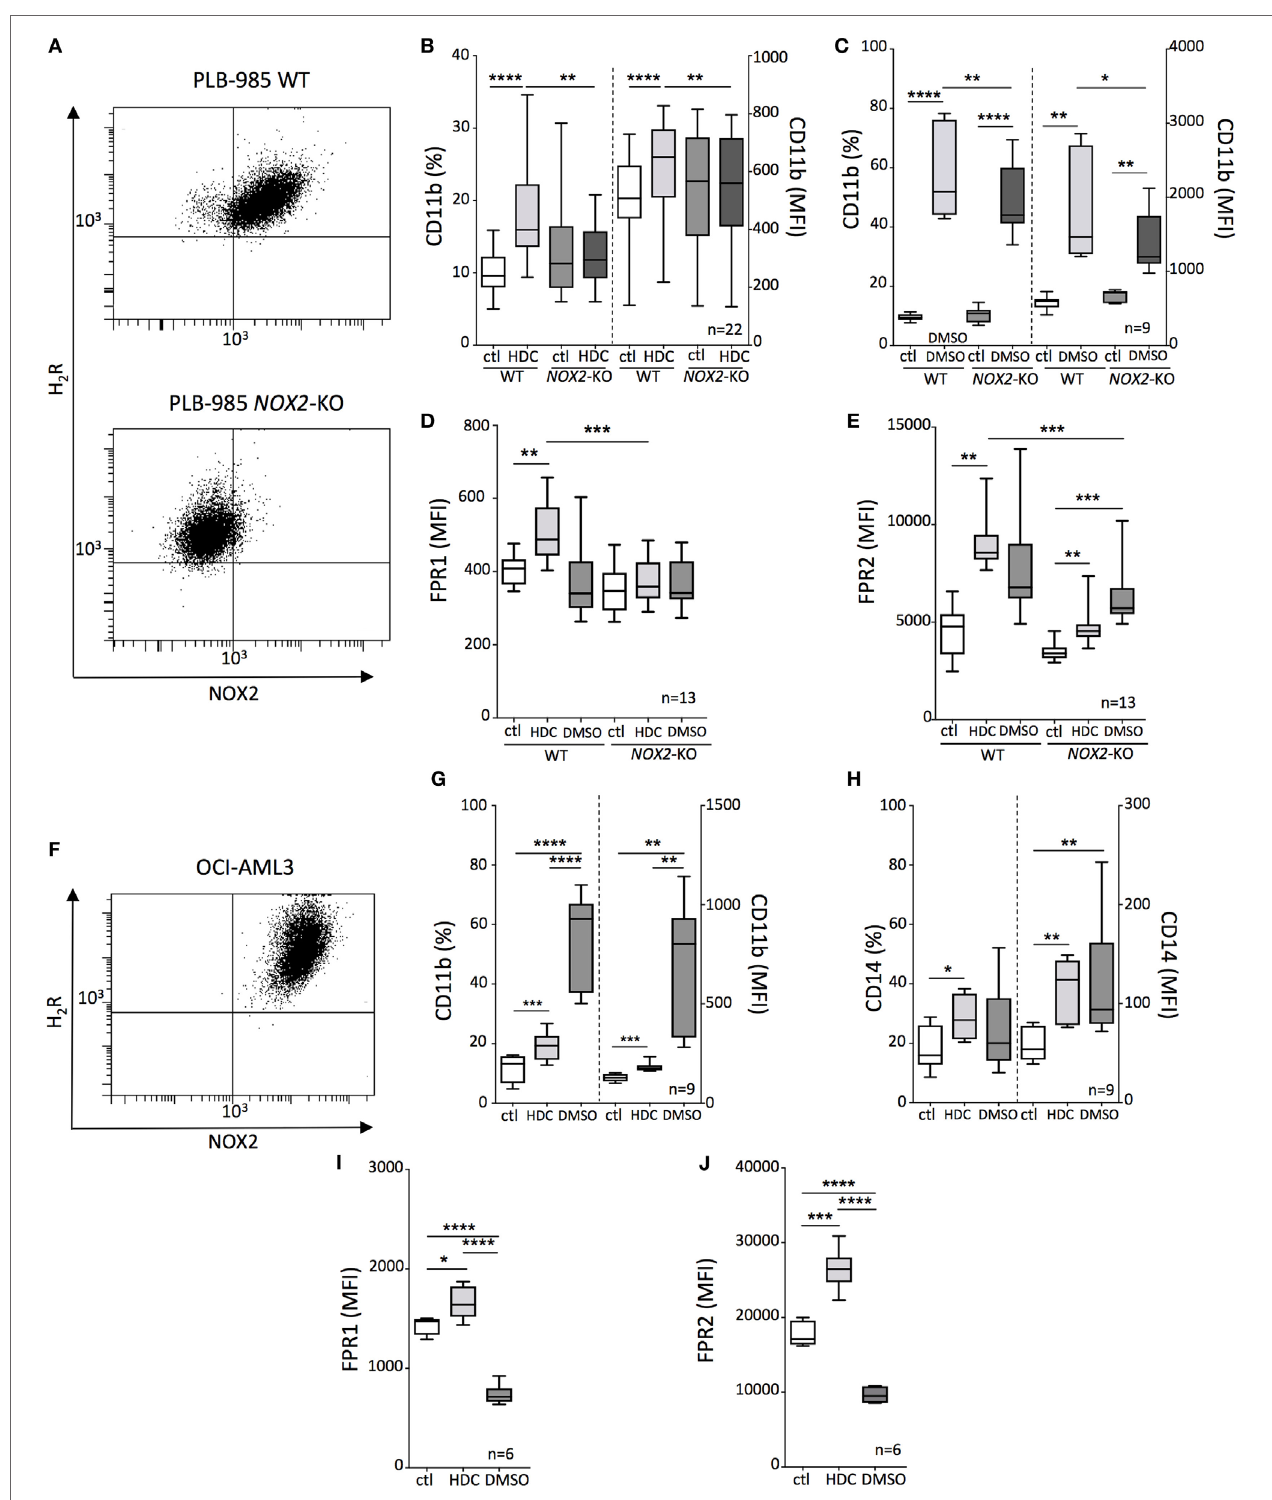
FigUre 1 | Histamine dihydrochloride (HDC)-induced differentiation of leukemic cells is NOX2-dependent. (a) FACS-plots showing NOX2 and H 2 R expression on wild-type (WT) and NOX2 -KO PLB-985 cells. Expression of CD11b (B,c) , FPR1 (D) , and FPR2 (e) on WT and NOX2 -KO PLB-985 cells cultured in the presence or absence of HDC or dimethyl sulfoxide (DMSO) as determined by flow cytometry. (F) FACS-plot showing NOX2 and H 2 R expression by OCI-AML3 cells. Expression of CD11b (g) , CD14 (h) , FPR1 (i) , and FPR2 (J) on OCI-AML3 cells cultured in the presence or absence of HDC or DMSO. Abbreviations: MFI, median fluorescence intensity. ANOVA; * p < 0.05, ** p < 0.01, *** p < 0.001, **** p <